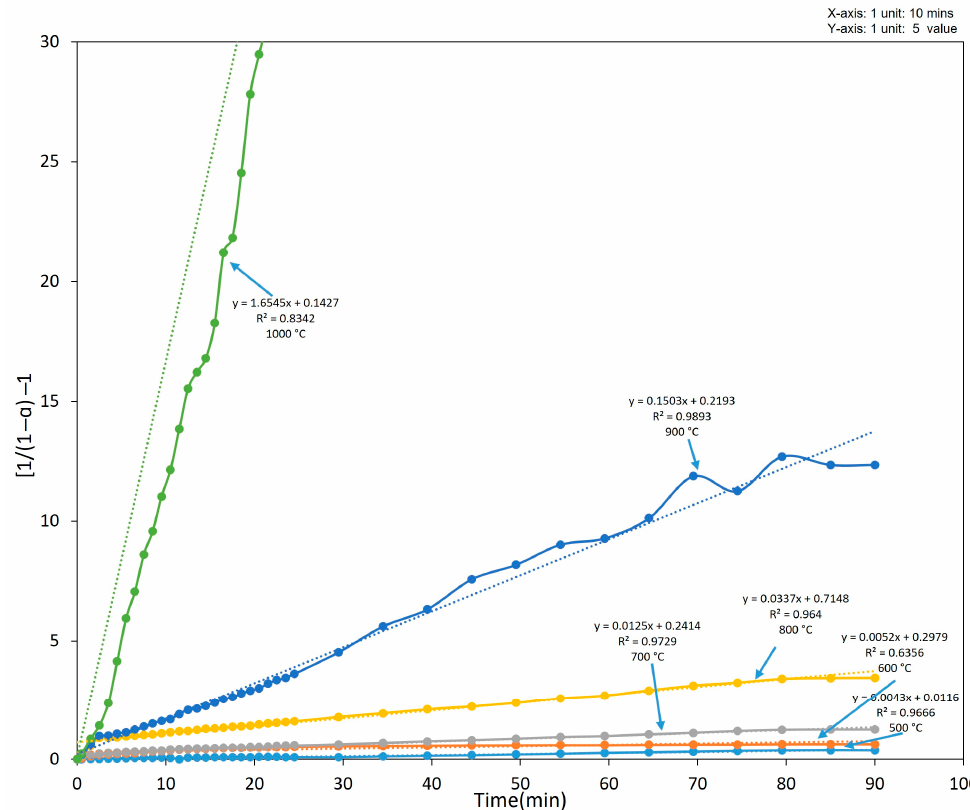
Figure 19. Relation between [1/(1 − α )] − 1 and time for different reduction temperatures. Table 3. Kinetic models for reduction reaction